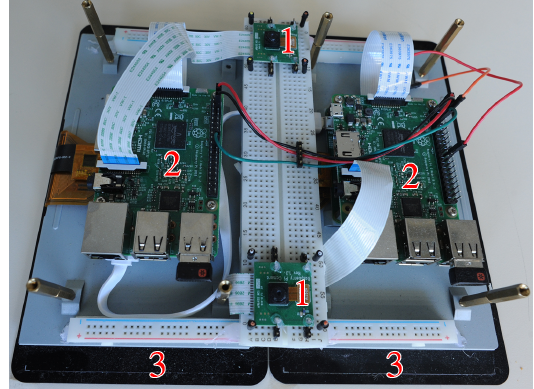
Figure 3. The hardware platform used for image acquisition